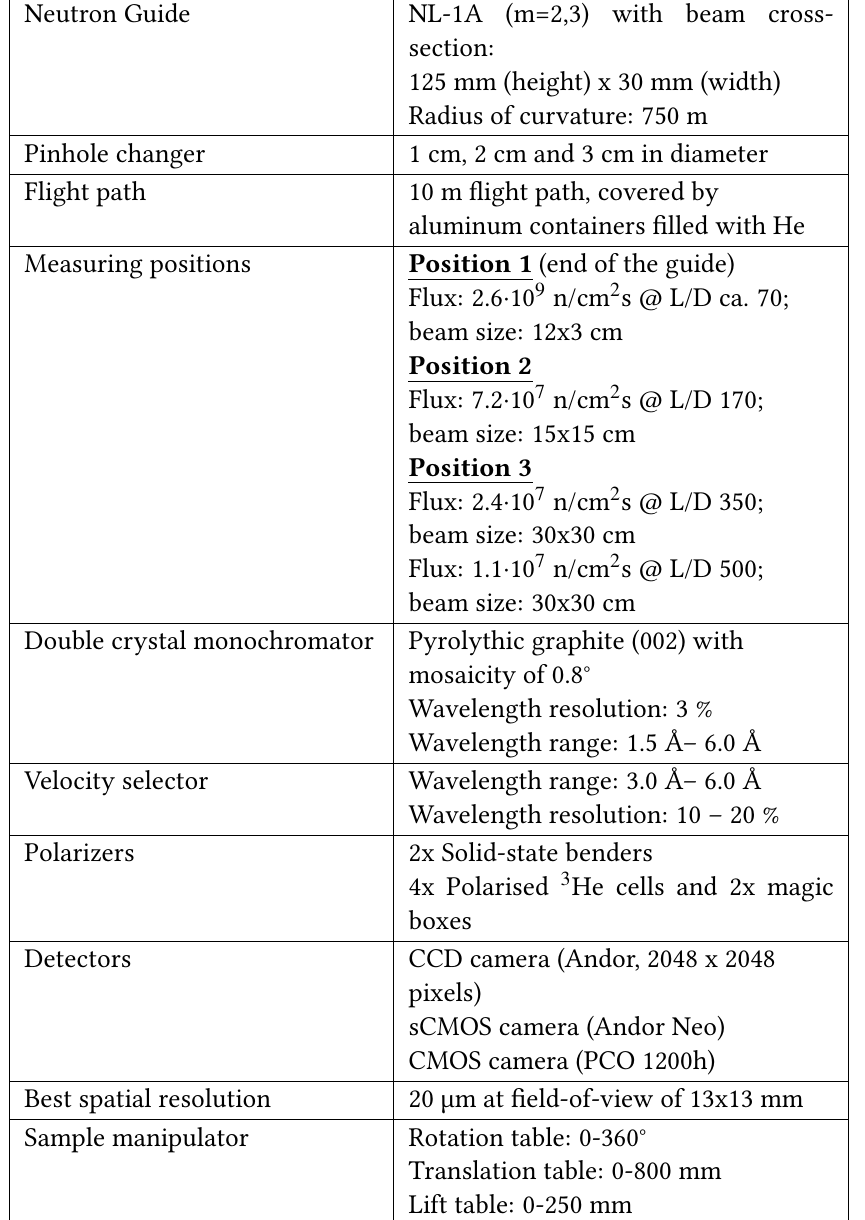
Translation table: 0-800 mm Lift table: 0-250 mm Table 1: Technical parameters of